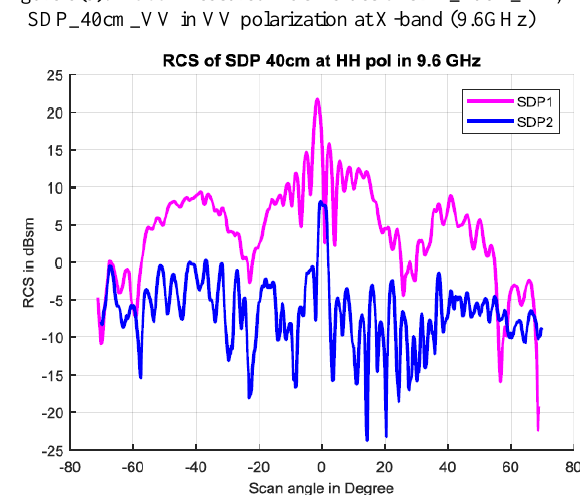
Figure 5(b): Plot of measured RCS values of SDP_40cm_HH, SDP_40cm_VV in HH polarization at X-band (9.6GHz)